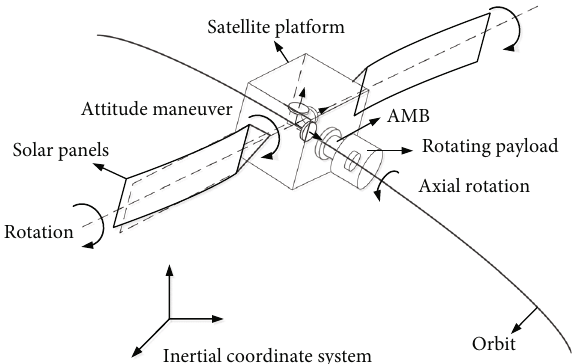
Figure 1: Structure of the RPS